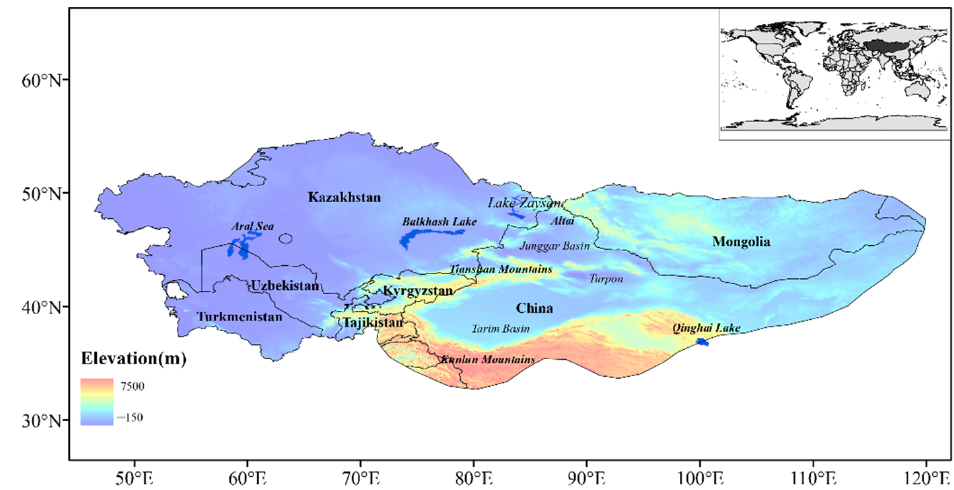
Figure 1. The Pan-Central-Asia arid region.